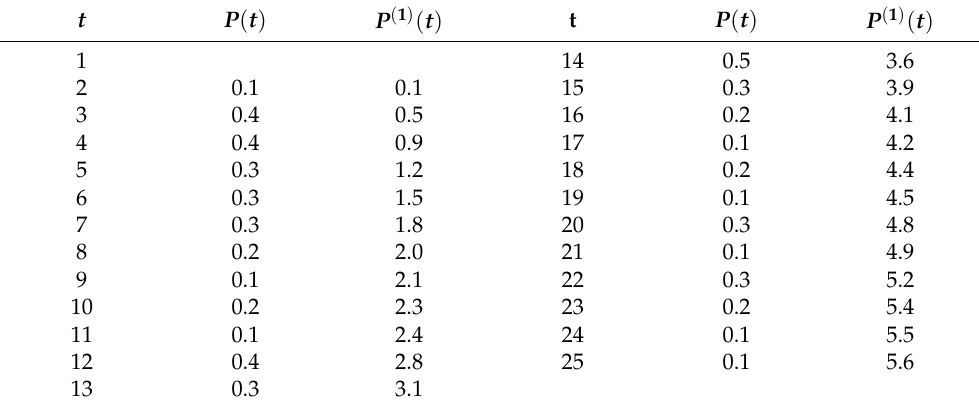
on values from t = 2 to t = 25 (fitting period). Table 11. AGO series of transformed stationary